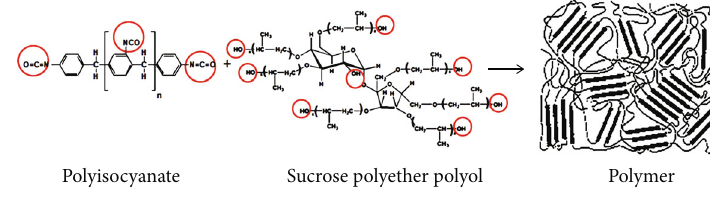
Figure 1: Principle of gel reaction.